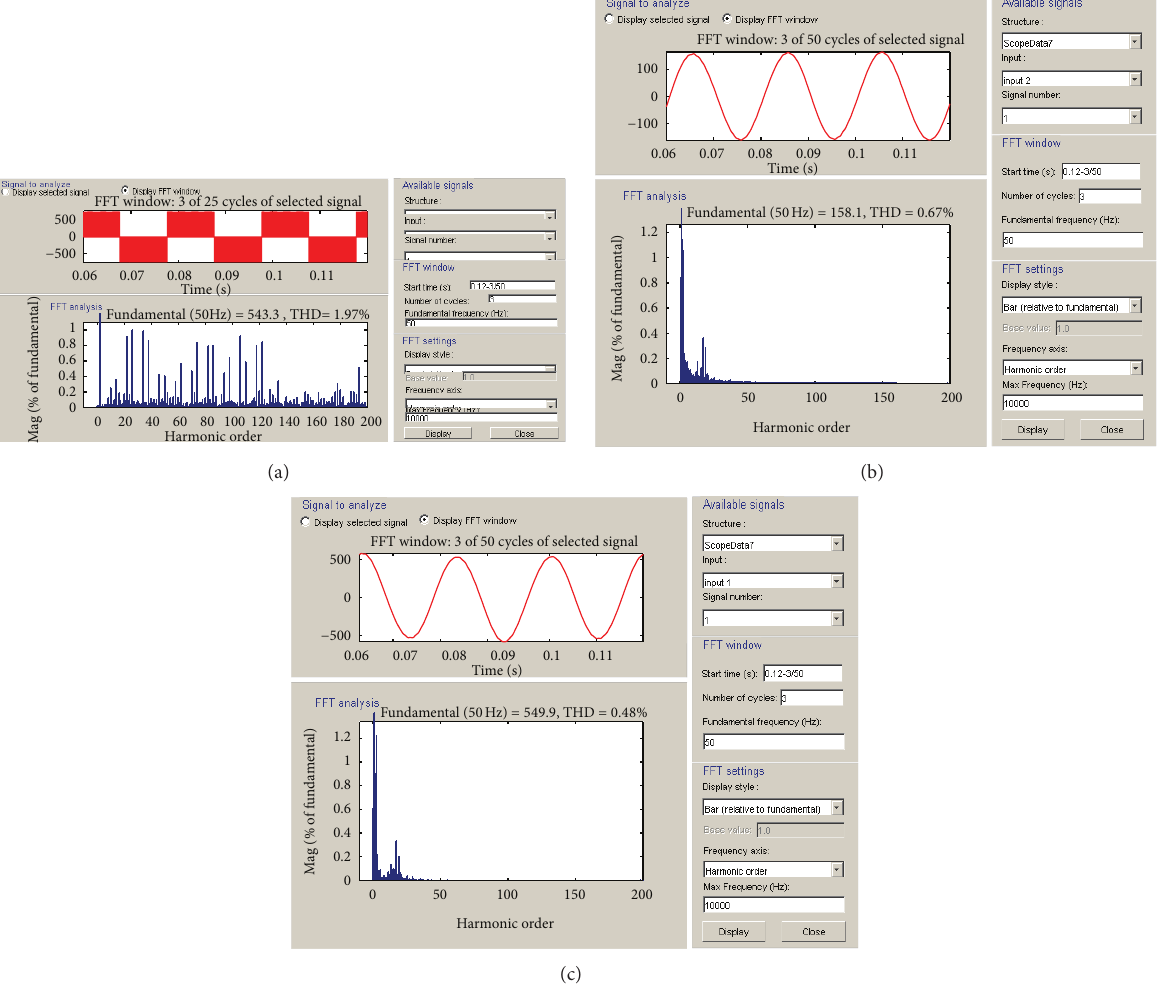
Figure 11: (a) The THD analyses of inverter voltage, (b) inverter current and the (c) grid or load voltage at 10kHz switching frequency.